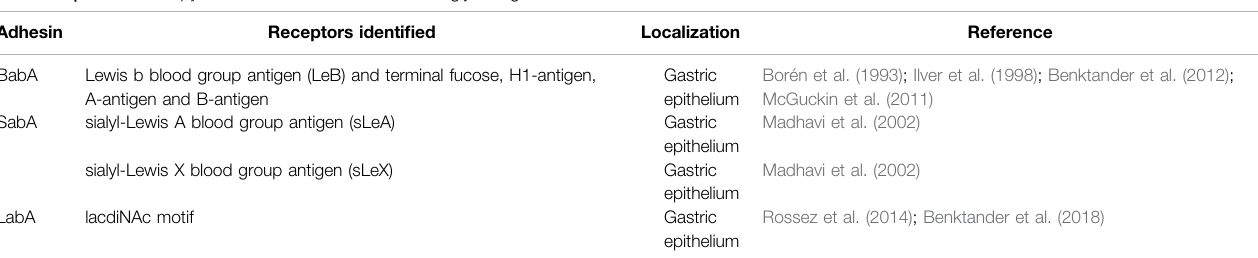
TABLE 1 | Helicobacter pylori adhesins and their described glycan ligands.